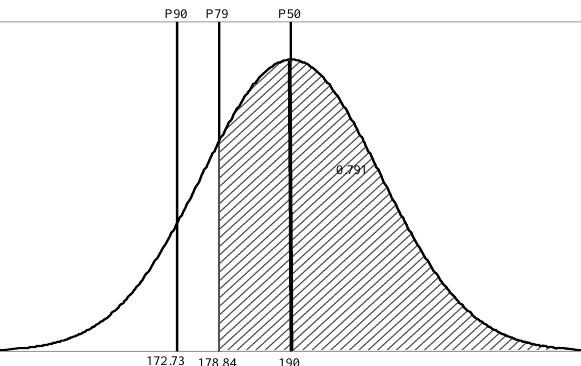
Figure 4. The normal distribution plot of production rate (in thousands), Mean=190, σ=13.477.